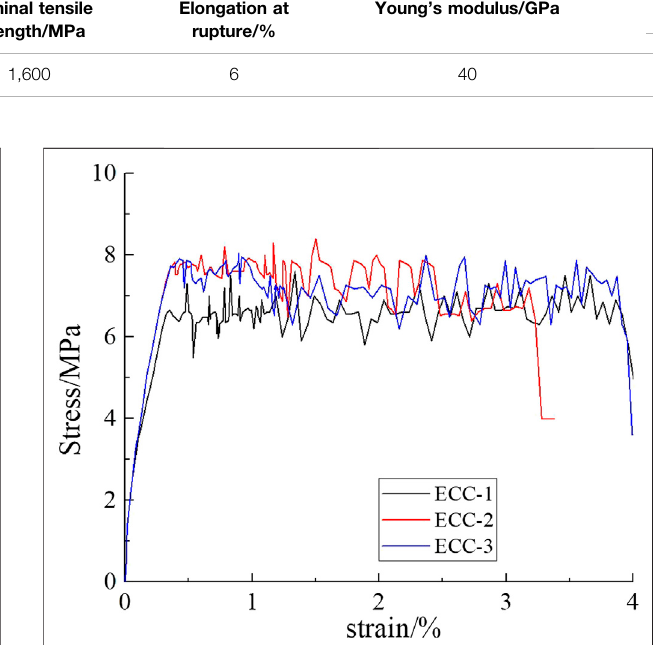
FIGURE 2 | Tensile test results for ECC.